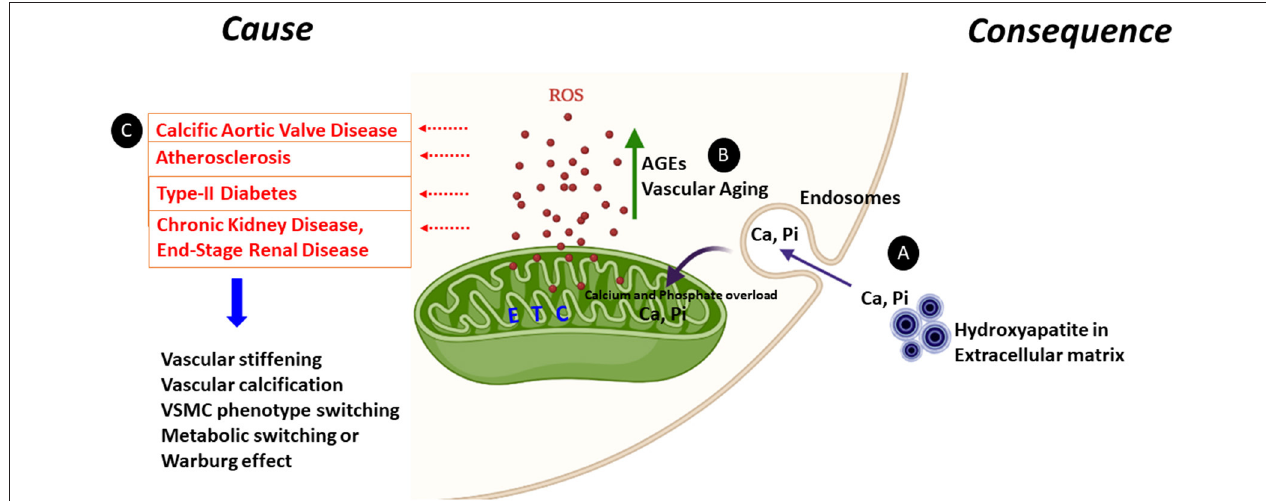
FIGURE 1 | Mitochondrial dysfunction as a cause or consequence of vascular calcification. Increased ROS generation and mineral dysregulation via damaged mitochondrial electron transport chain (ETC) complexes are the likely key cause and consequence of mitochondrial dysfunction observed during vascular calcification. (A) Calcium released from the hydroxyapatite crystals from the extracellular matrix can enter the cytoplasm via endosomes and make its way to the mitochondrial matrix causing calcium (Ca) and phosphate (Pi) overload. This calcium and phosphate overload can damage the electron transport chain complexes and generate ROS. (B) AGEs are glycotoxins which are elevated in diabetes. AGEs and the receptor for AGEs (RAGE) generate ROS from mitochondria and play a significant role in accelerating the vascular calcification process by enhanced synthesis of extracellular matrix components. Furthermore, ROS production is enhanced in aging vascular cells. (C) Enhanced ROS leads to vascular stiffening, vascular calcification, VSMC transition to osteoblast or chondrocyte-like cells and the metabolic switching from oxidative phosphorylation to glycolysis. All these pathways are commonn denominators in pathologies including calcific aortic valve disease, atherosclerosis, type-II diabetes, CKD, and